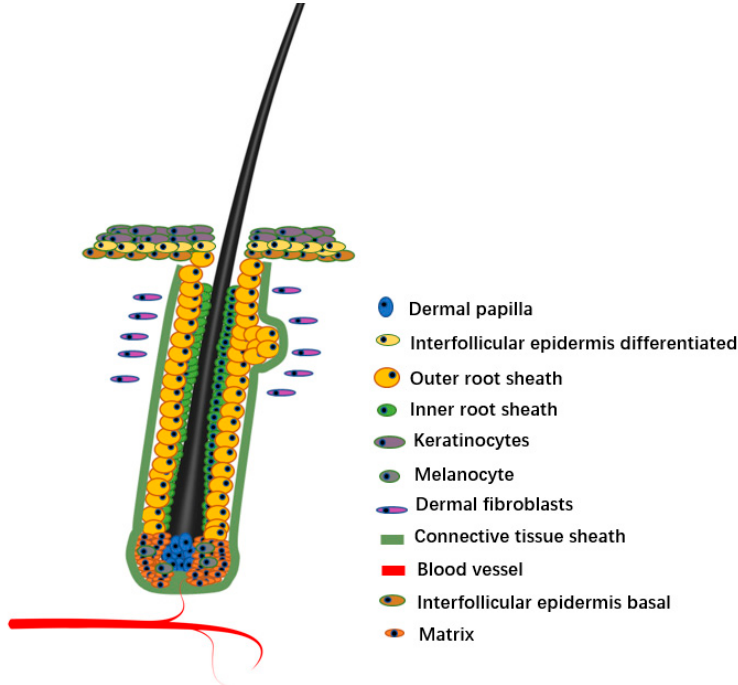
Figure 1. Hair follicle structure.